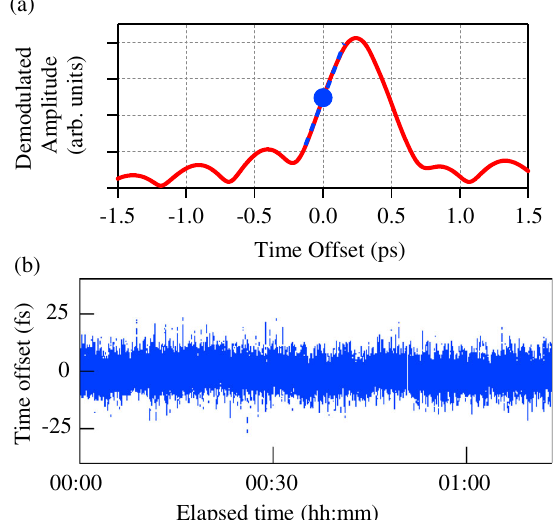
FIG. 3. (a) Heterodyne cross-correlation amplitude between the two clock pulse trains versus their time offset. The blue dashed line indicates the linear range of response. (b) Typical measured out-of-loop time offset Δ T over a 4-km air path based on the heterodyne amplitude. While synchronized, the standard deviation is 2.4 fs.